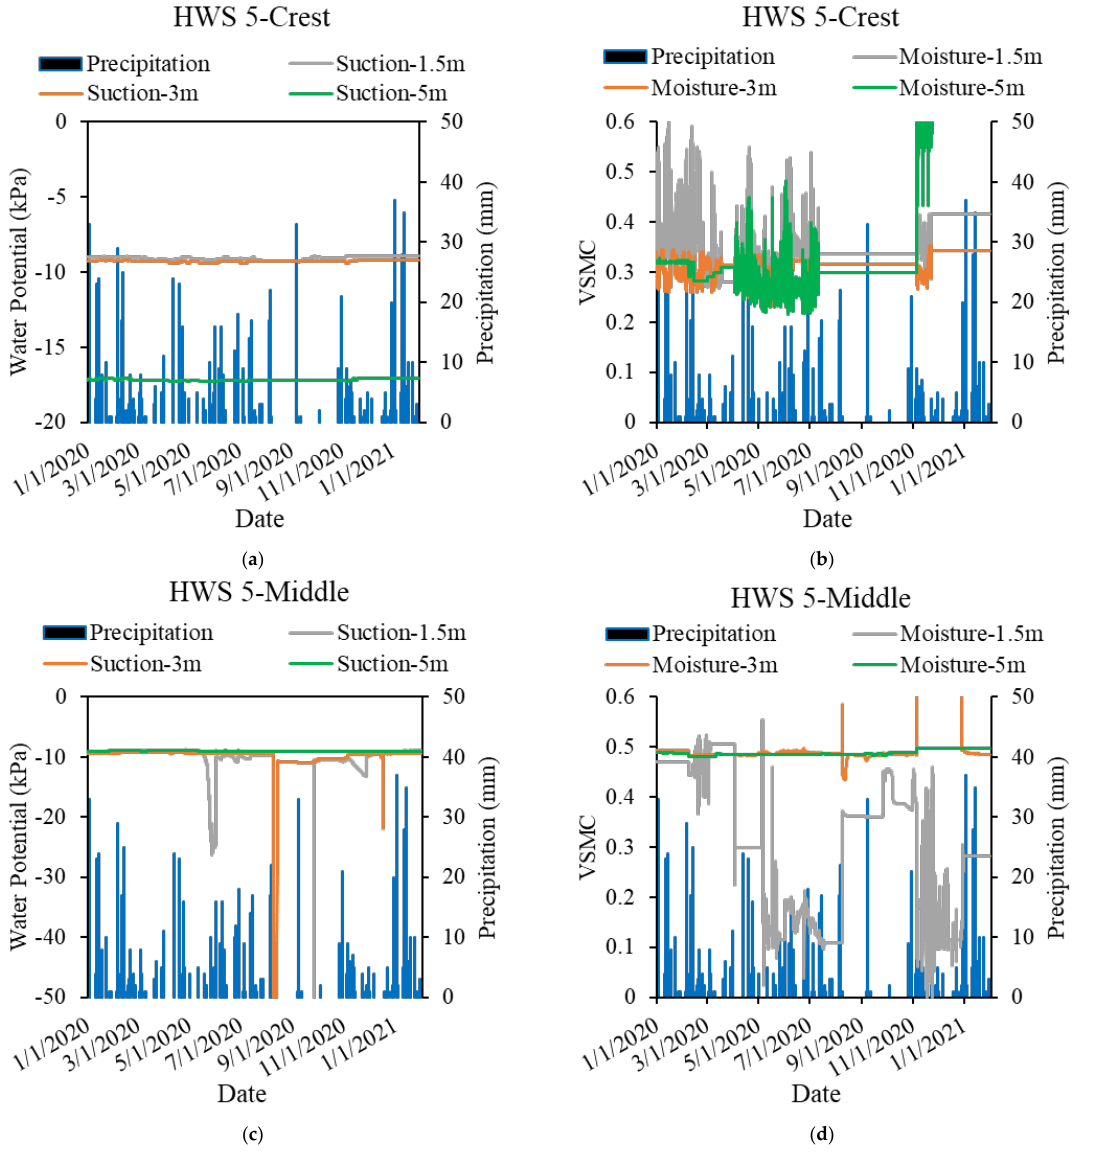
Figure 25. HWS 5 in situ variations with rainfall ( a ) SMS across the crest of the slope ( b ) VSMC across the crest of the slope ( c ) SMS across the middle of the slope ( d ) VSMC across the middle of the slope (1 m = 3.28 ft; 1 mm = 0.039 in; 1 kPa = 20.89 psf). (1 m = 3.28 ft; 1 mm = 0.039 in; 1 kPa = 20.89